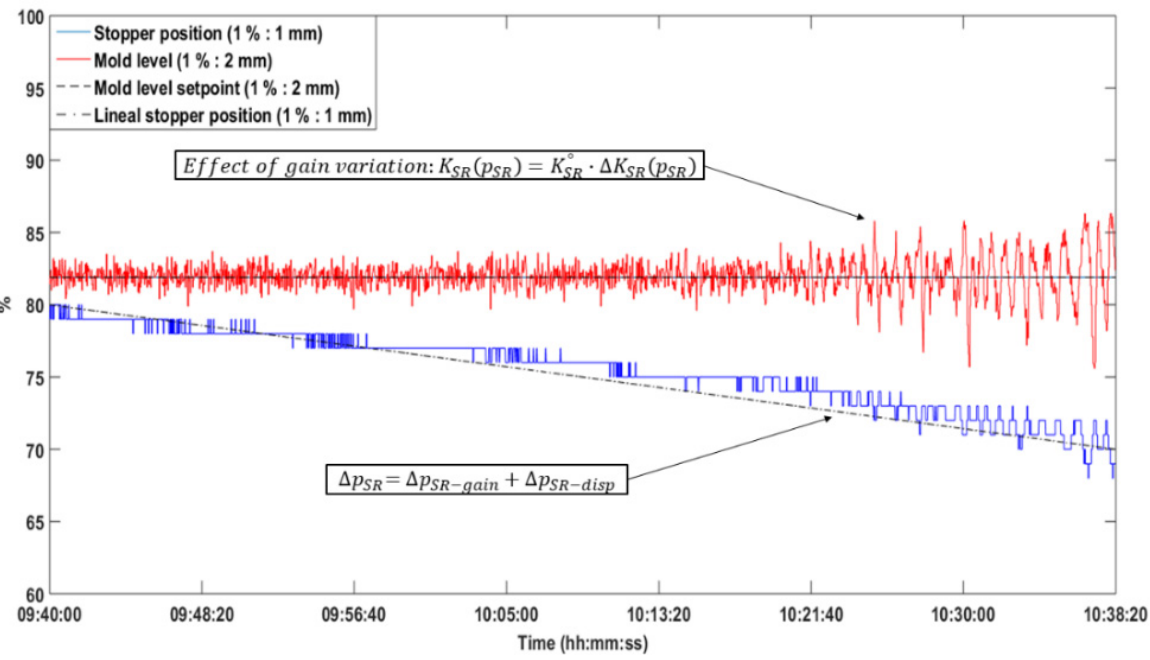
Figure 3. Real data from a cast with SR erosion in the case study.